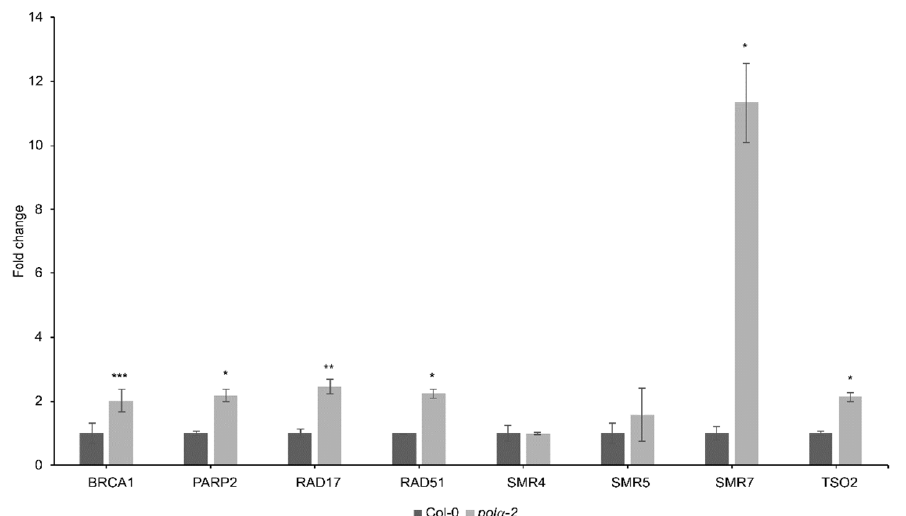
Figure 4. Analysis of DNA damage response genes in the pol α -2 mutant. Transcript levels of several DNA damage-related genes were measured in root tips of 7-d-old seedlings by qRT-PCR. Data represent the mean ± SEM ( n = 3, minimum 100 root tips per repeat). Asterisks indicate statistical significance compared to Col-0 based on Student’s t-test; * p < 0.05; ** p < 0.01; *** p < 0.001.